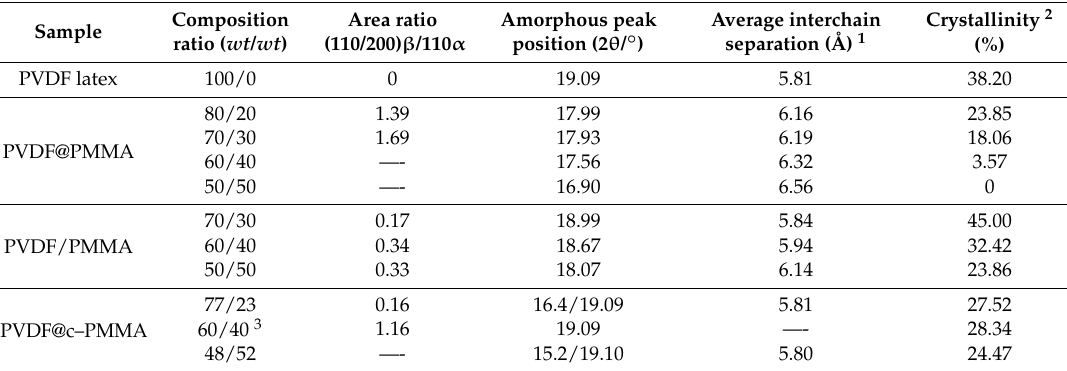
Table 2. Some parameters obtained from X-ray deconvolution